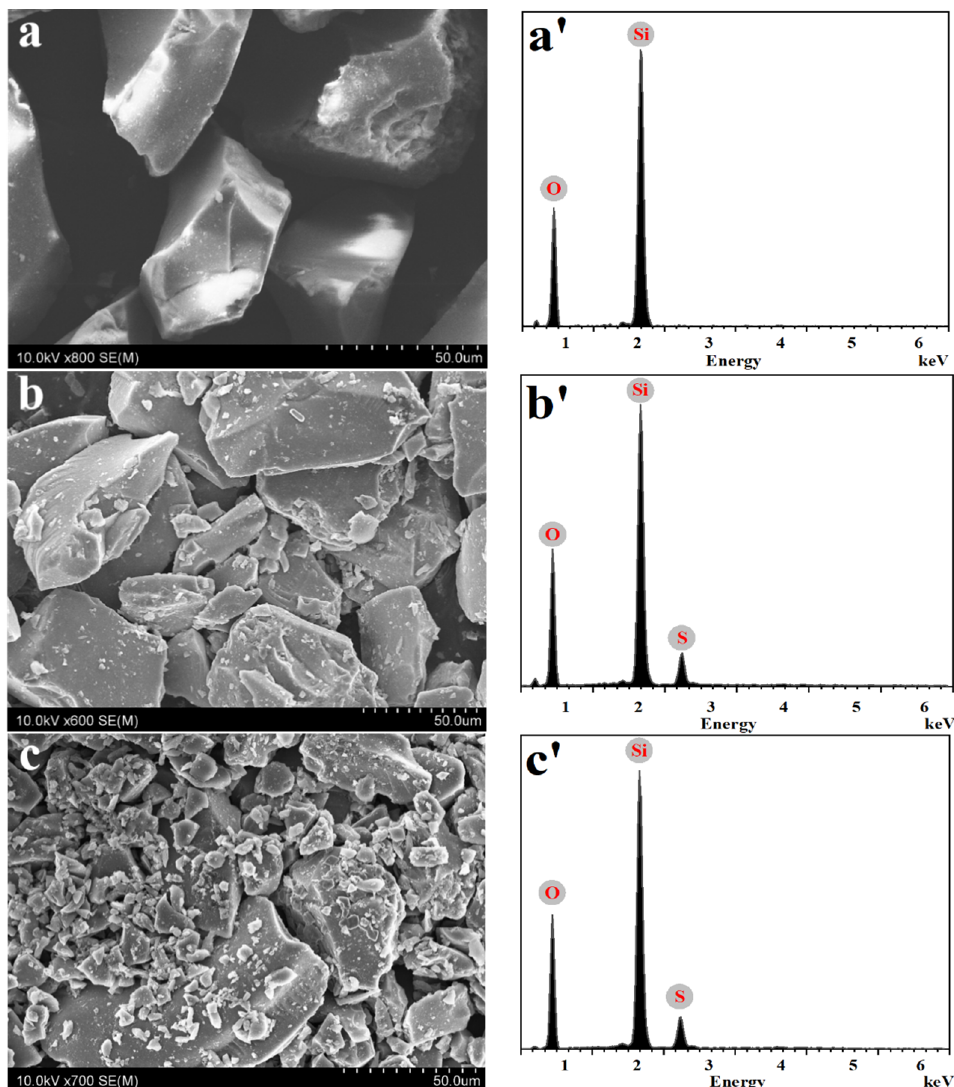
Figure 2. SEM images and EDS spectra of SG ( a , a’ ), SSA(E) − 4 ( b , b’ ) and SSA(W) − 4 ( c , c’ ).